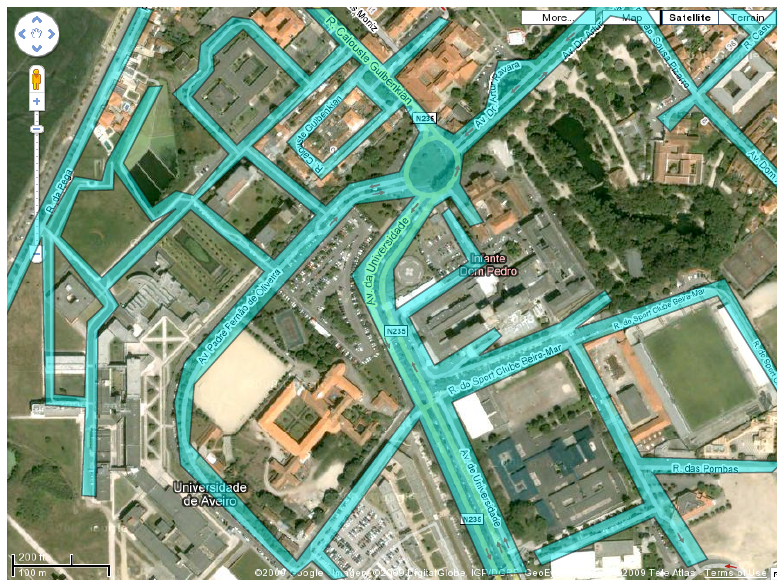
Figure 1. The blue polygonal region models a street